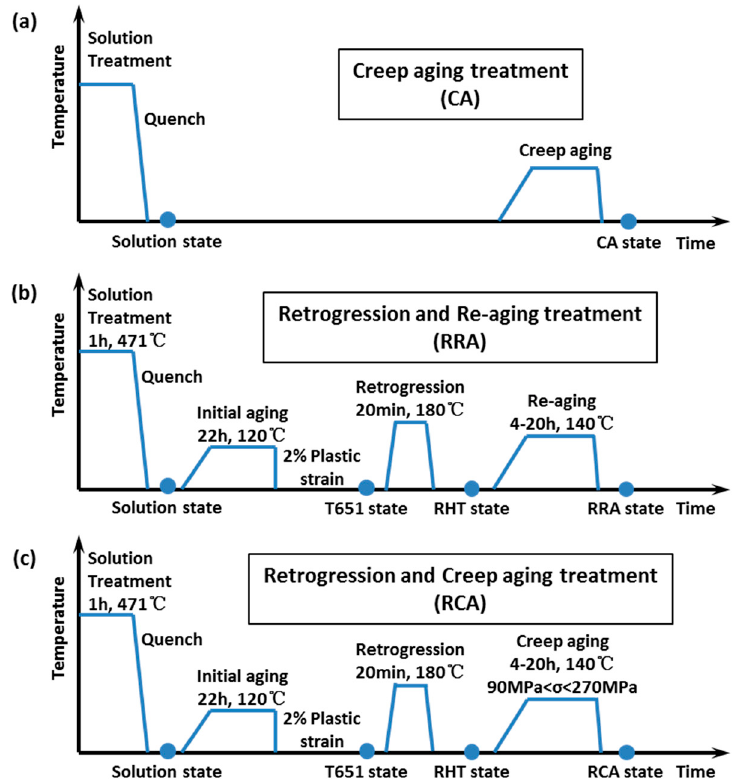
Figure 2. Scheme of the various heat treatments.